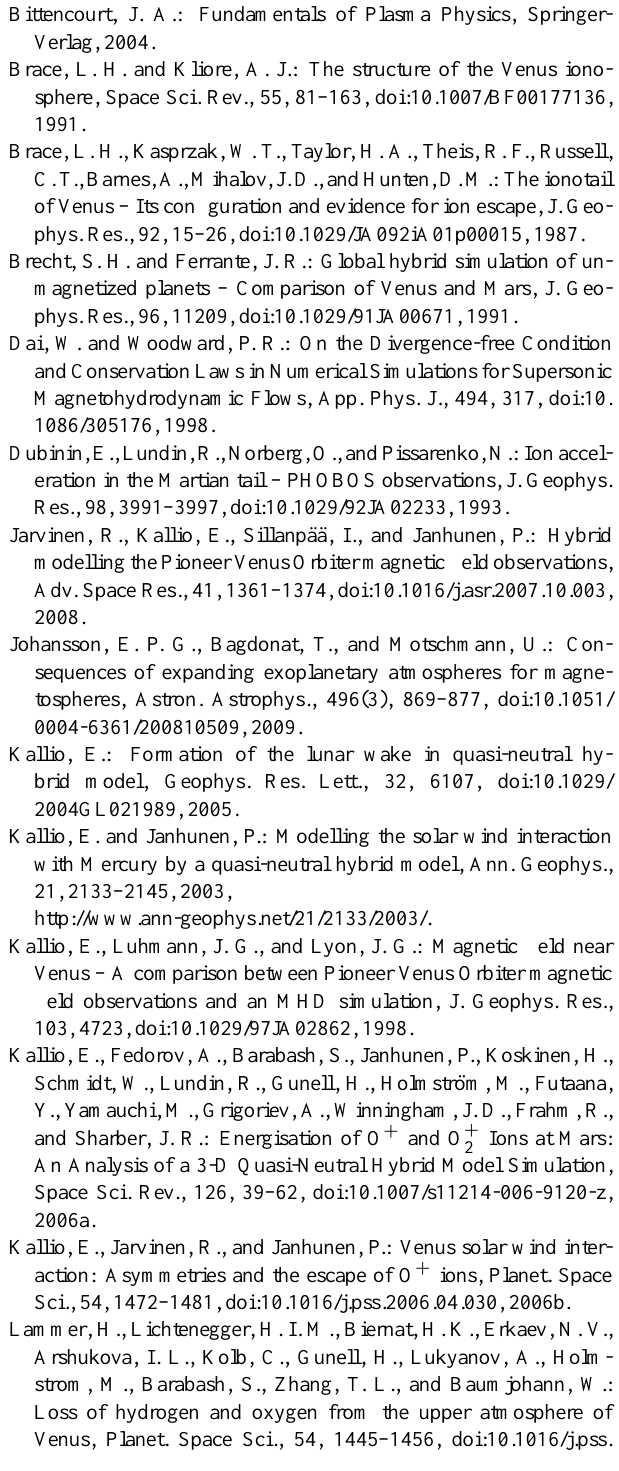
Fig. 3 were exported from the cl software written by E. Penou (CESR). Figure 9 was created using the VisIt open source visual- ization